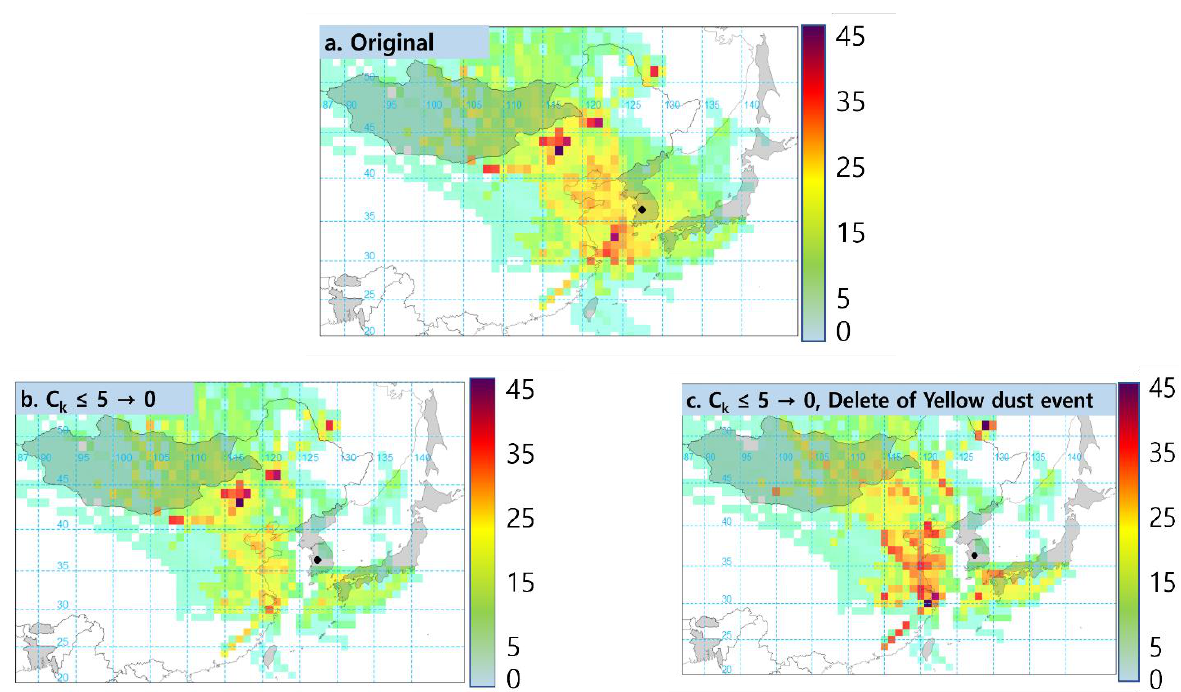
Figure 8. PM 2.5 mass concentrations using a CWT model. ( a ) Original CWT; ( b ) C k ≤ 5, MCWT; and ( c ) C k ≤ 5, delete of yellow dust event, MCWT .